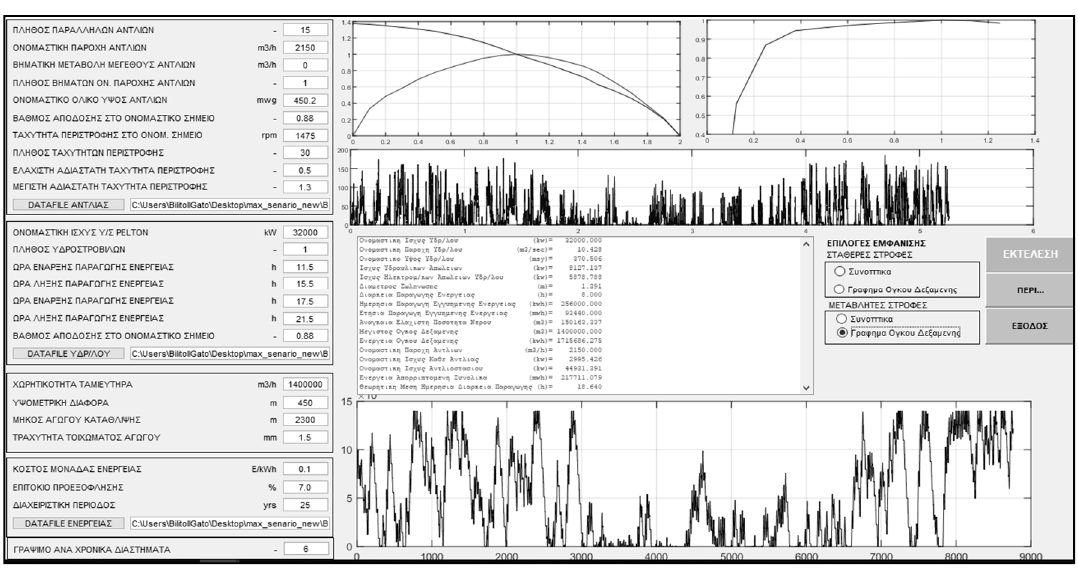
Figure 7. Graphical interface of the developed simulation model for the proposed PSP in Matlab.